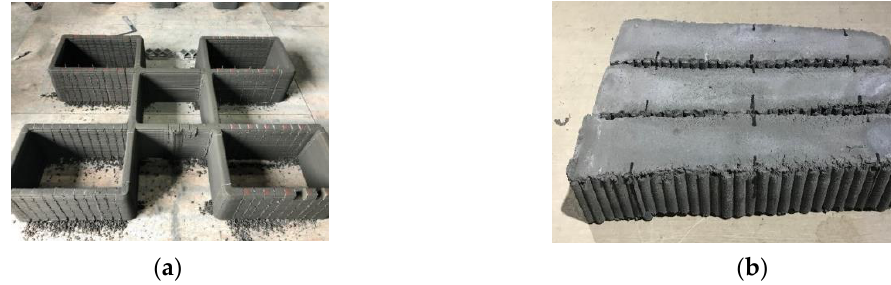
Figure 9. Process of extracting specimens. ( a ) Cutting process; ( b ) Cutting surface.